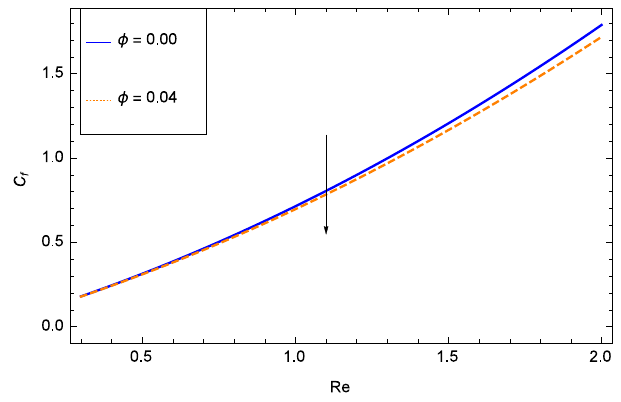
Figure 22. Skin friction coefficient ( C f ) when h = − 0.40, β 1 = 2.00, M = 0.10, Pr = 6.80 and various values of φ against Reynolds number Re for (CuO-H 2 O).